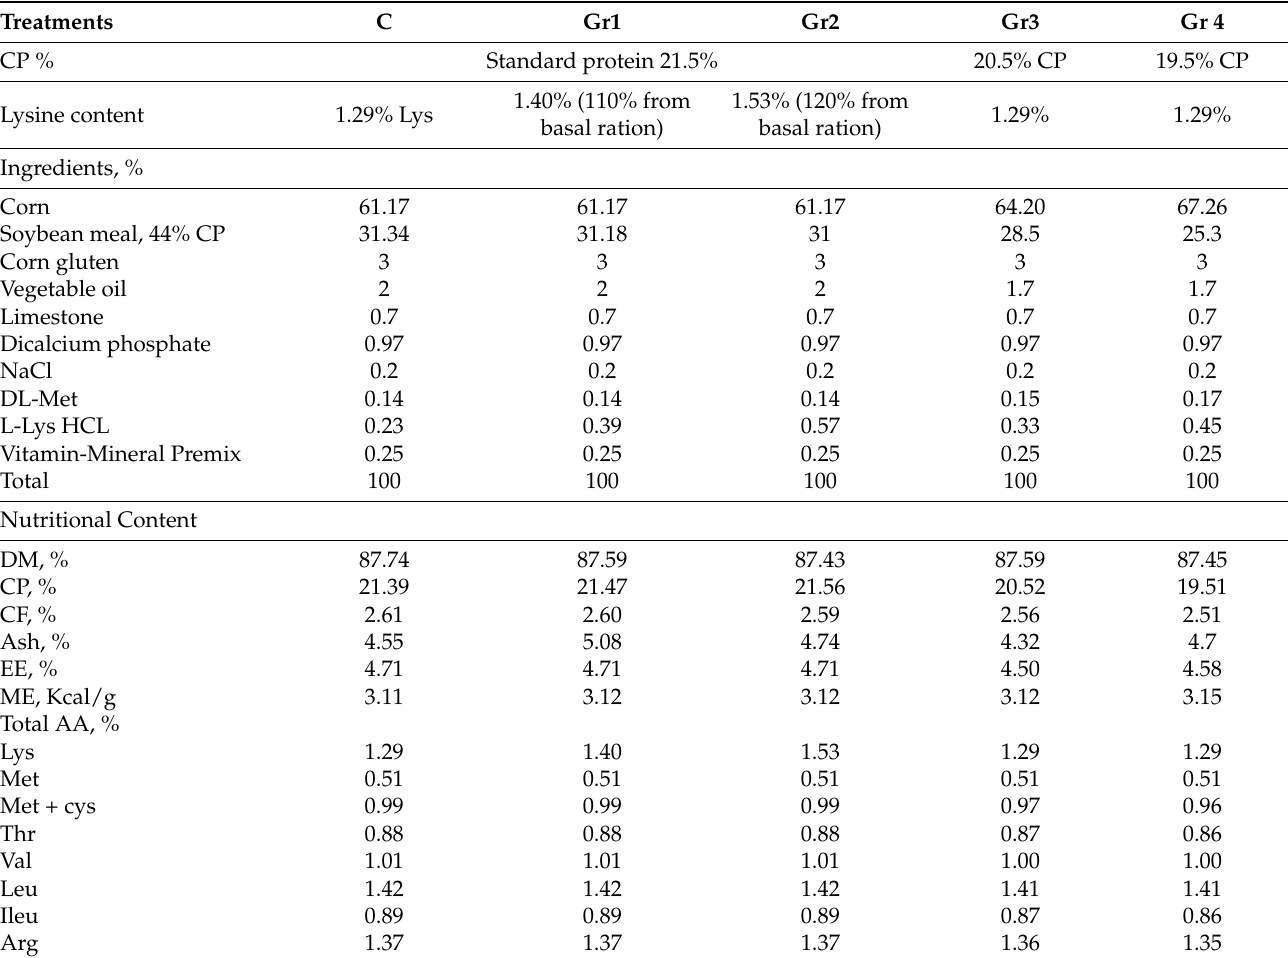
Table 2. The composition of the experimental diets and proximate chemical analysis during the growing